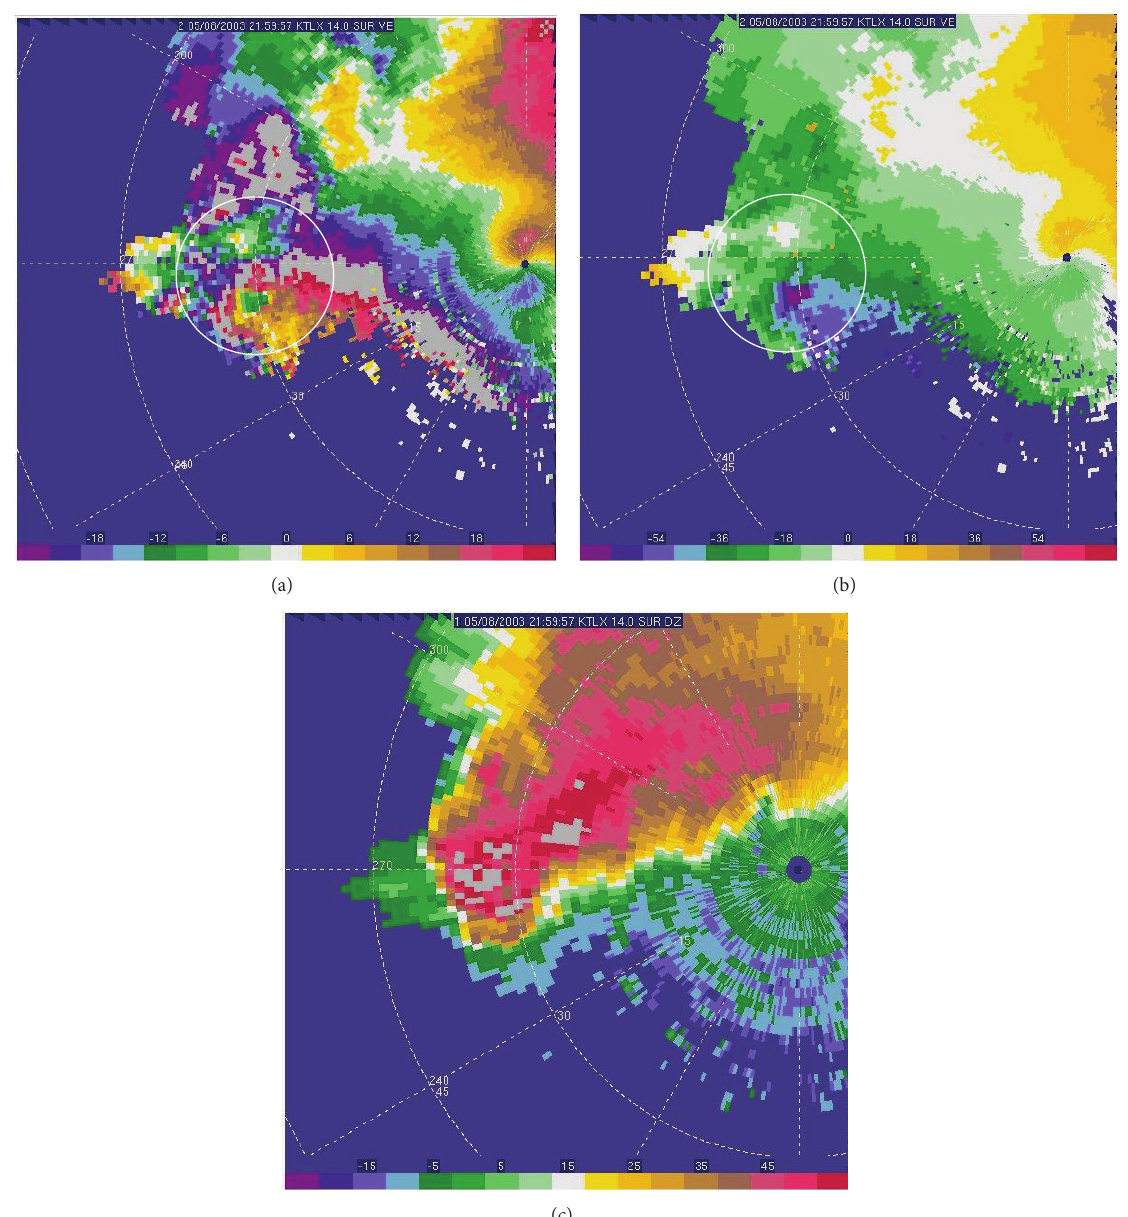
Figure 4: Raw (a) and dealiased (b) radial velocity and (c) reflectivity data on the 14 degree elevation surface from KTLX valid at 2159 UTC on 8 May 2003. The region of twice-folded velocities is shown in the circled region. Note that the color scale for (a) has increments of 3 m/s while (b) has increments of